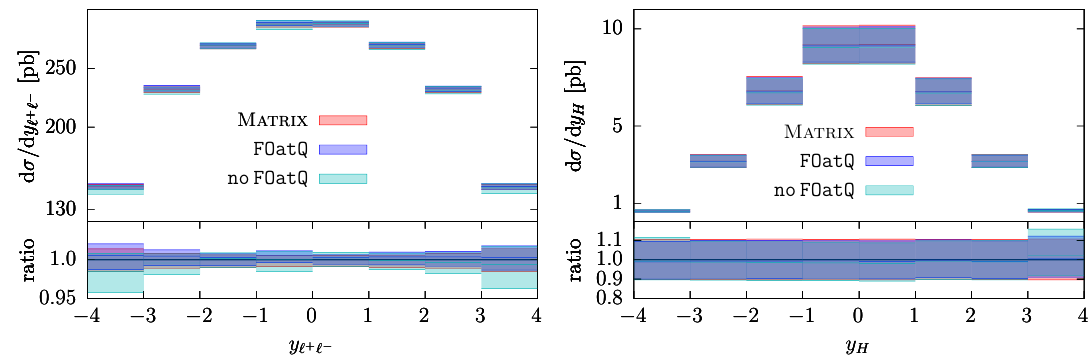
Figure 1 . Comparison between fixed-order predictions from Matrix against the two MiNNLO PS results (at “Les Houches” level) obtained using the original formulation of the method (labelled as no FOatQ ) and the new one presented in this work (labelled as FOatQ ). In the left pane we show the rapidity distribution of the dilepton system in Drell-Yan production, whereas in the right pane we show the Higgs boson rapidity. The ratios with respect to the Matrix results are also shown in the lower